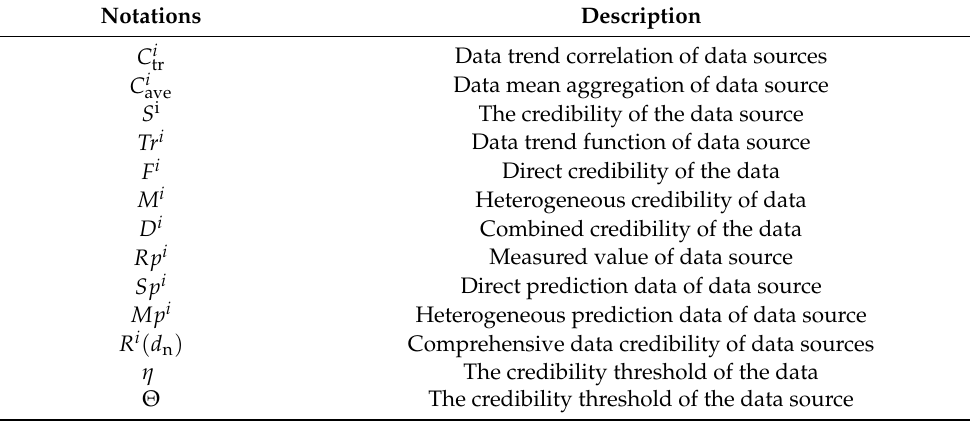
Table 1. Symbols and